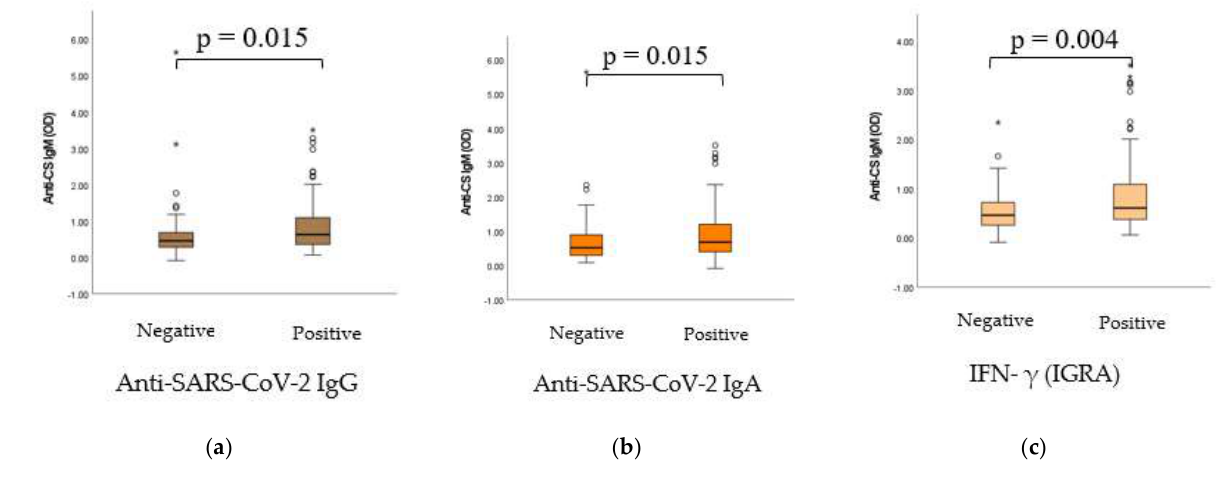
Figure 5. ( a ) Connection between the nAAb CS IgM anti-SARS-CoV-2 IgG positivity. ( b ) Connection between the nAAb CS IgM anti-SARS-CoV-2 IgA positivity. ( c ) Connection between the nAAb CS IgM IGRA (cellular response) positivity. Anti-SARS-CoV-2 IgG, IgA and IFN-γ qualitative (positive and negative) results were evaluated as per the manufacturer’s instructions. Anti-CS IgM absorbance (OD) results were handled as continuous, non-normally distributed integers and the alterations of titers were considered. Data are relative to the undivided, total sample cohort, without distinction between vaccination groups. The sample numbers were as follows: ( a ) anti-SARS-CoV-2 IgG negative/positive = 44/187, ( b ) anti-SARS-CoV-2 IgA negative/positive = 117/123 and ( c ) IFN- γ (IGRA) negative/positive = 53/199. Total = 255.